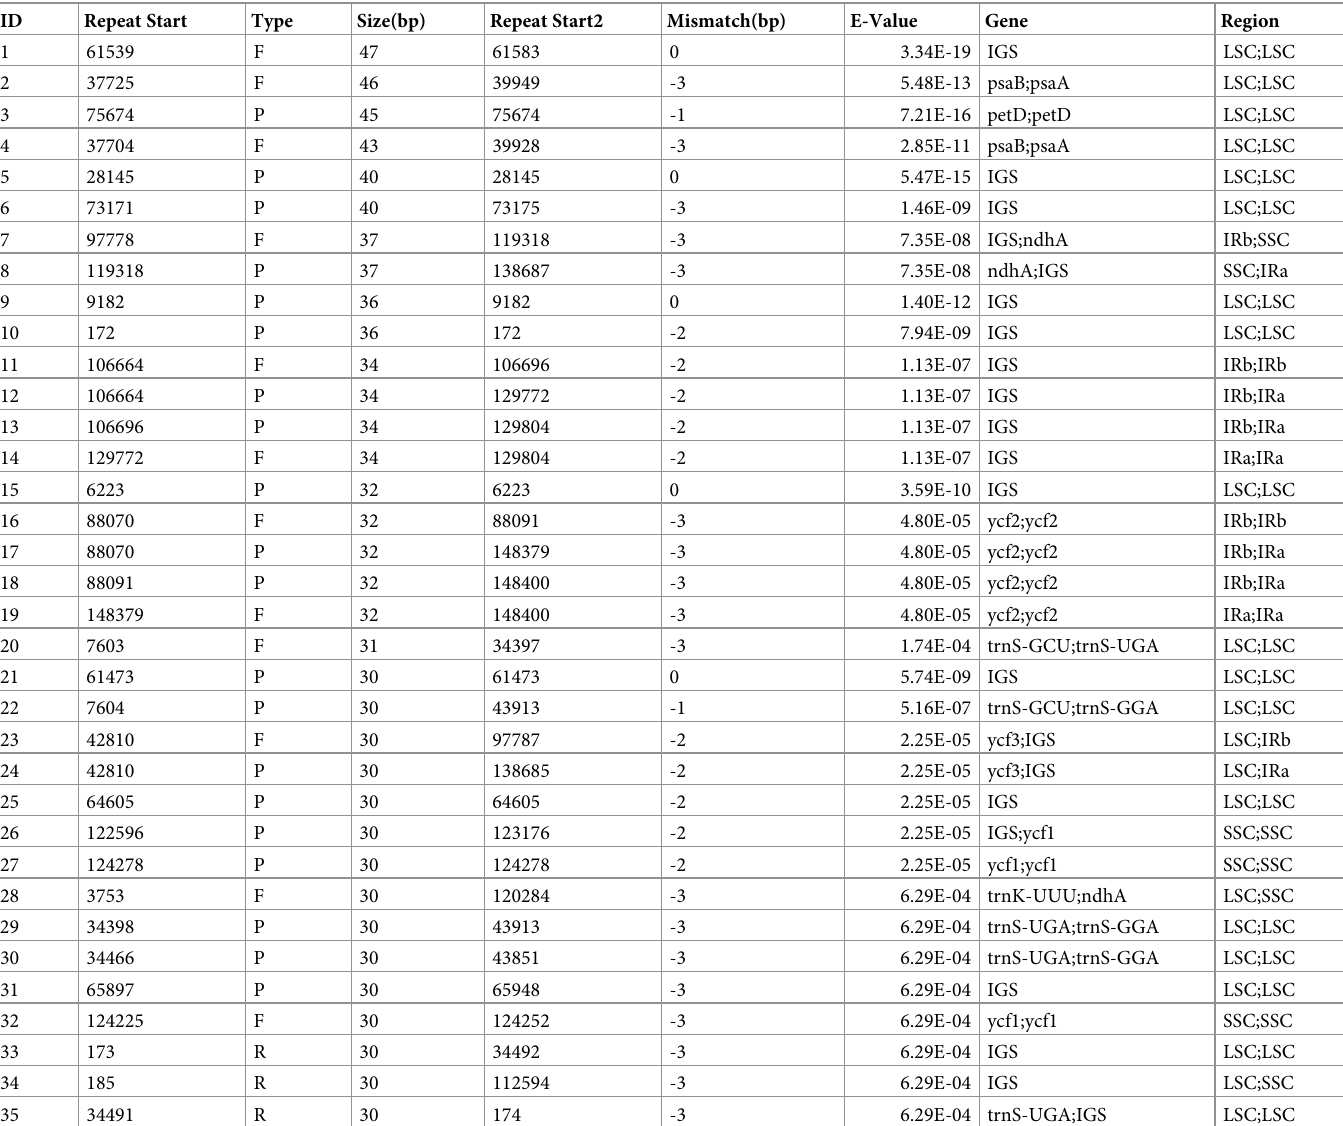
Table 7. Repeat sequences in the broccoli chloroplast genome.